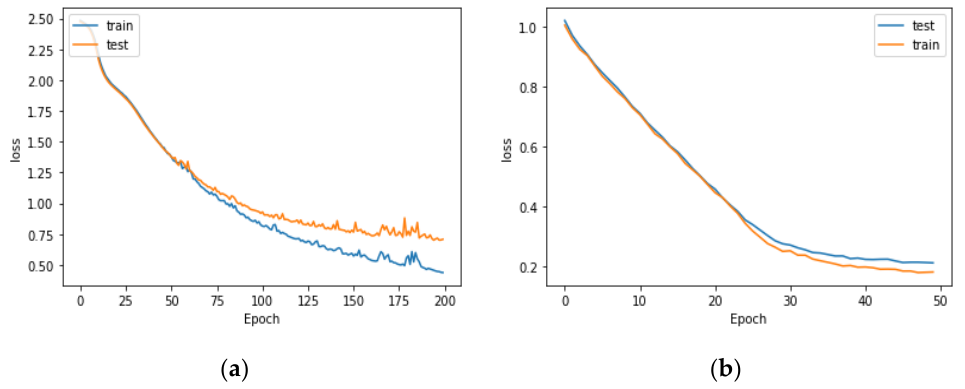
Figure 11. Comparison of training loss curves. ( a ) LSTM classification model training and ( b ) our algorithm training.